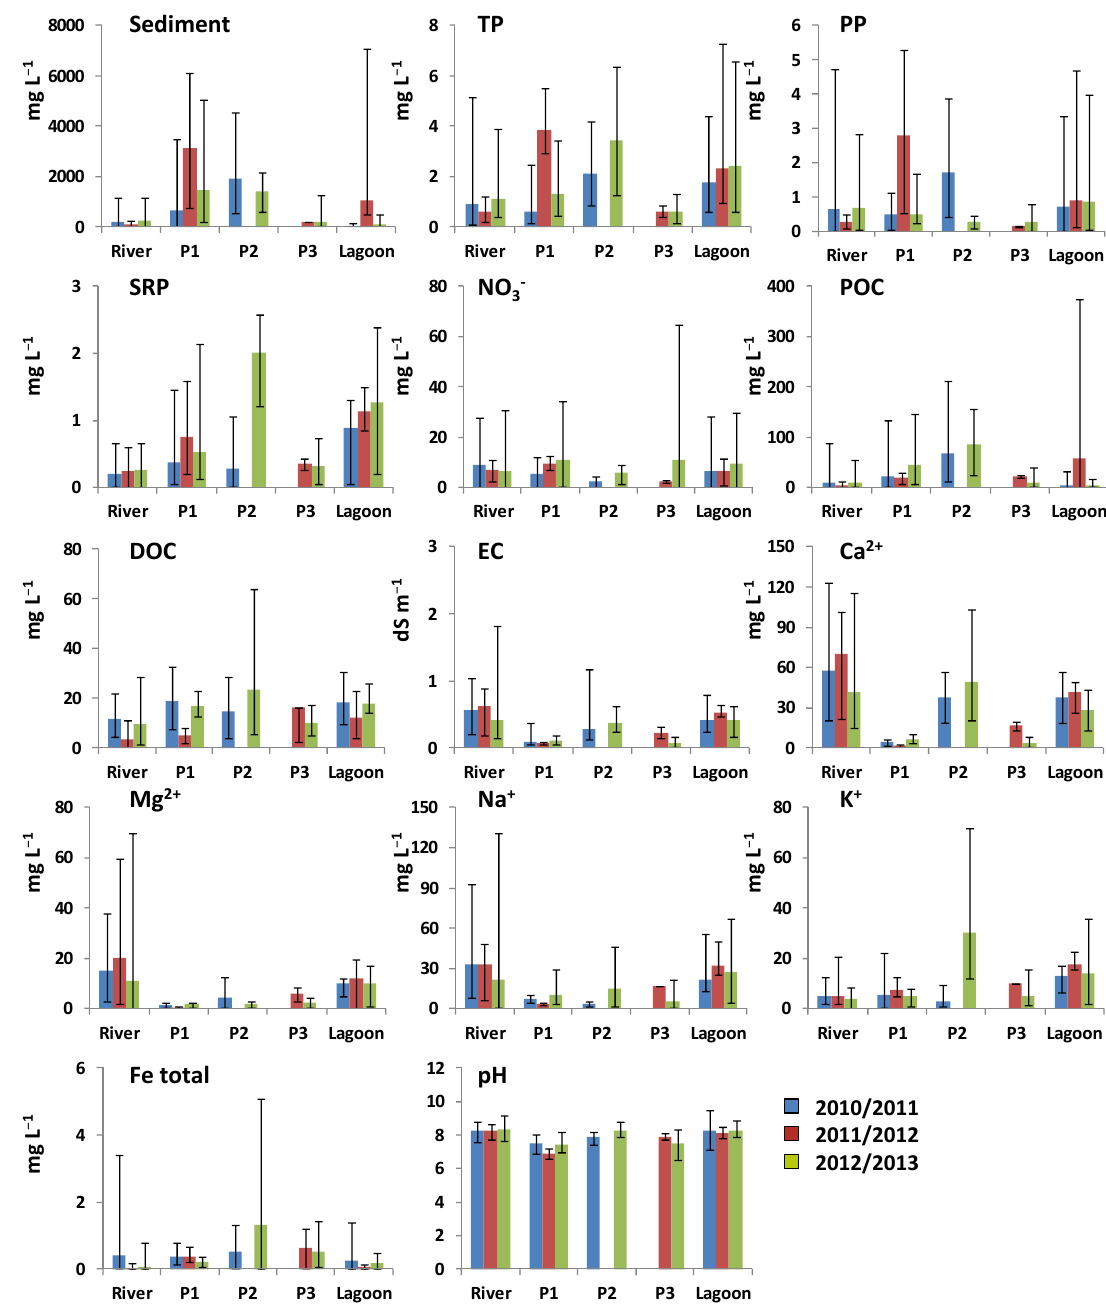
Figure 4. Sediment and nutrient concentrations in the Enxoé River, erosion plots (P1, P2 and P3) and lagoon (TP, total phosphorus; PP, particulate phosphorus; SRP, soluble reactive phosphorus; POC, particulate organic carbon; DOC, dissolved organic carbon; EC, electrical conductivity). Vertical bars refer to maximum and minimum values monitored.